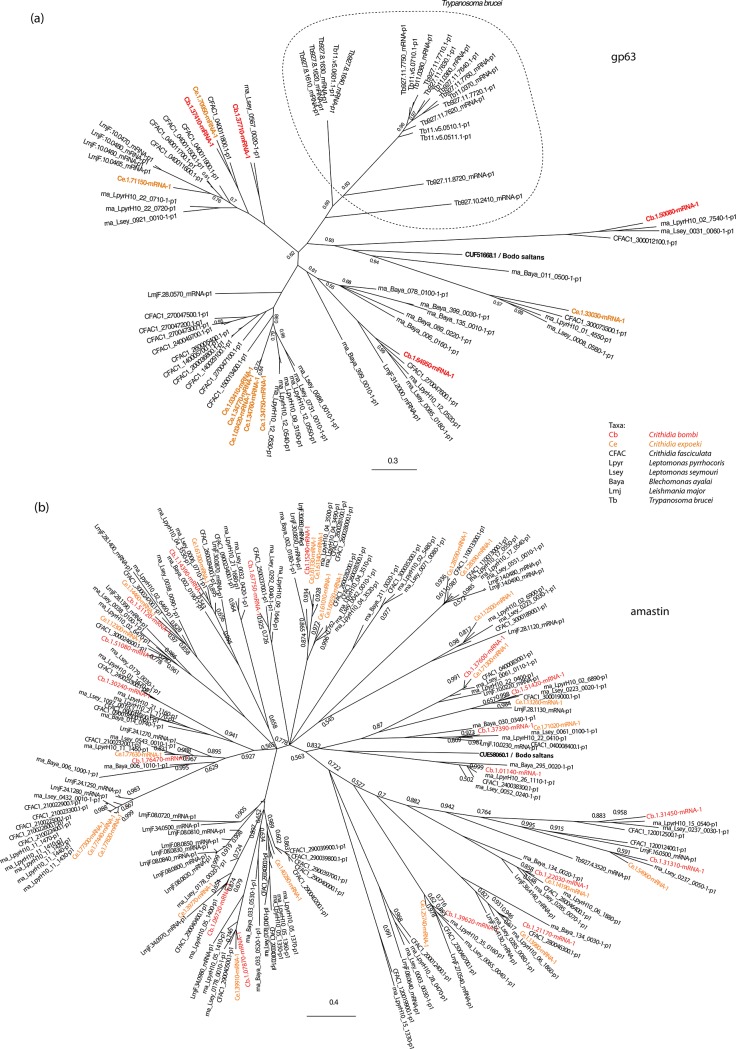
Phylogenetic relationships of orthologous proteins.Phylogenetic relationships of orthologous proteins in C. bombi and C. exppoeki, and as identified by OMA. Unrooted trees visualized with FigTree v.1.4.2 [70]; sequences from C. bombi (in red), and C. expoeki (in orange) shown in colour for clarity. Sequences of Bodo saltans (Kinetoplastida, Bodonidae; in bold black) represent a distant, outgroup kinetoplastid. Labels are as in TriTryp data base, and as named here for the two species under study. Branch values are posterior probabilities (PP), only values of PP < 1 shown here, all other cases have reported PP = 1. The horizontal bar is relative number of mutations per site. (a) gp63-like proteins. A total of 80 aligned, orthologous sequences were subjected to MrBayes (default settings, with 11 Mio generations and 25% burn-in fraction; convergence, S.D. of split frequencies < 0.004) to construct the consensus tree shown here. (b) amastin-like proteins. Tree from aligned, orthologous sequences submitted to MrBayes (default settings, 25% burn-in, with 12.6 Mio generations; convergence, S.D. of split frequencies = 0.01).